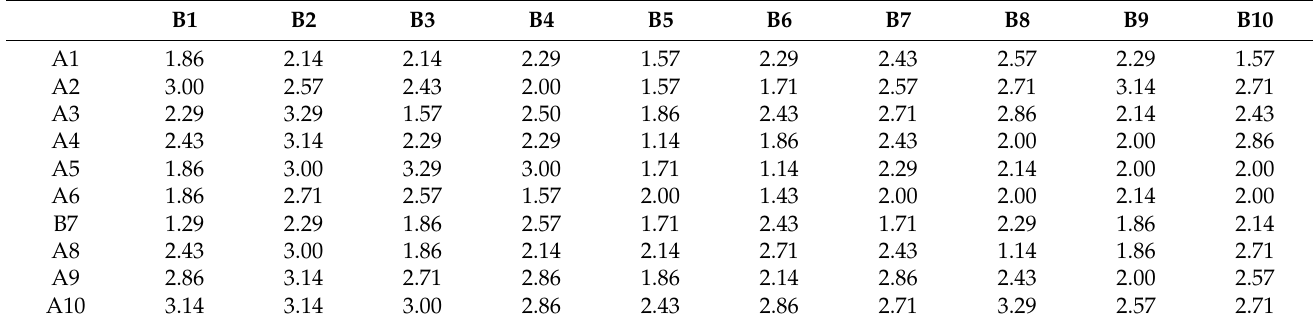
Table 11. Association matrix of risk factors and resilience indexes. (A × B).